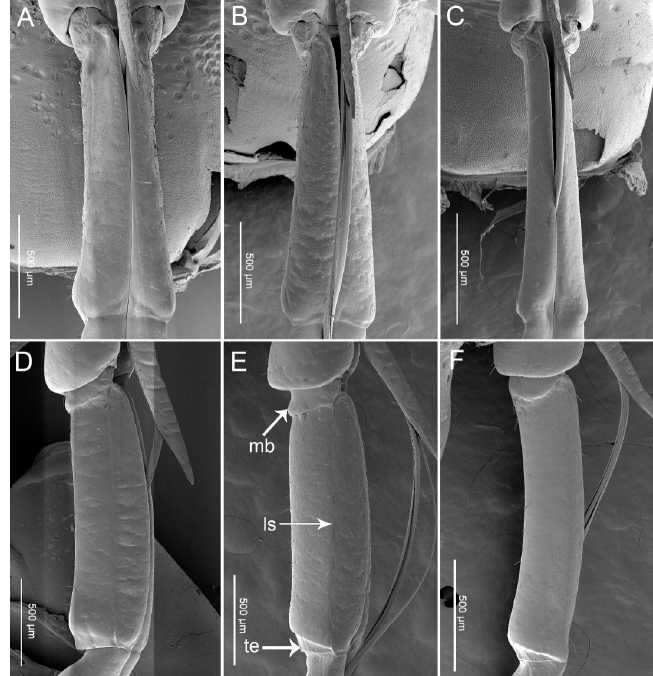
Figure 6. SEM images of the second labial segment. ( A ) Ventral view of Picromerus bidens ; ( B ) Ventral view of Picromerus lewisi ; ( C ) Ventral view of Cazira bhoutanica ; ( D ) Lateral view of Picromerus bidens ; ( E ) Lateral view of Picromerus lewisi ; ( F ) Lateral view of Cazira bhoutanica ; mb, membrane; ls, longitudinal suture; te, tapered edge.